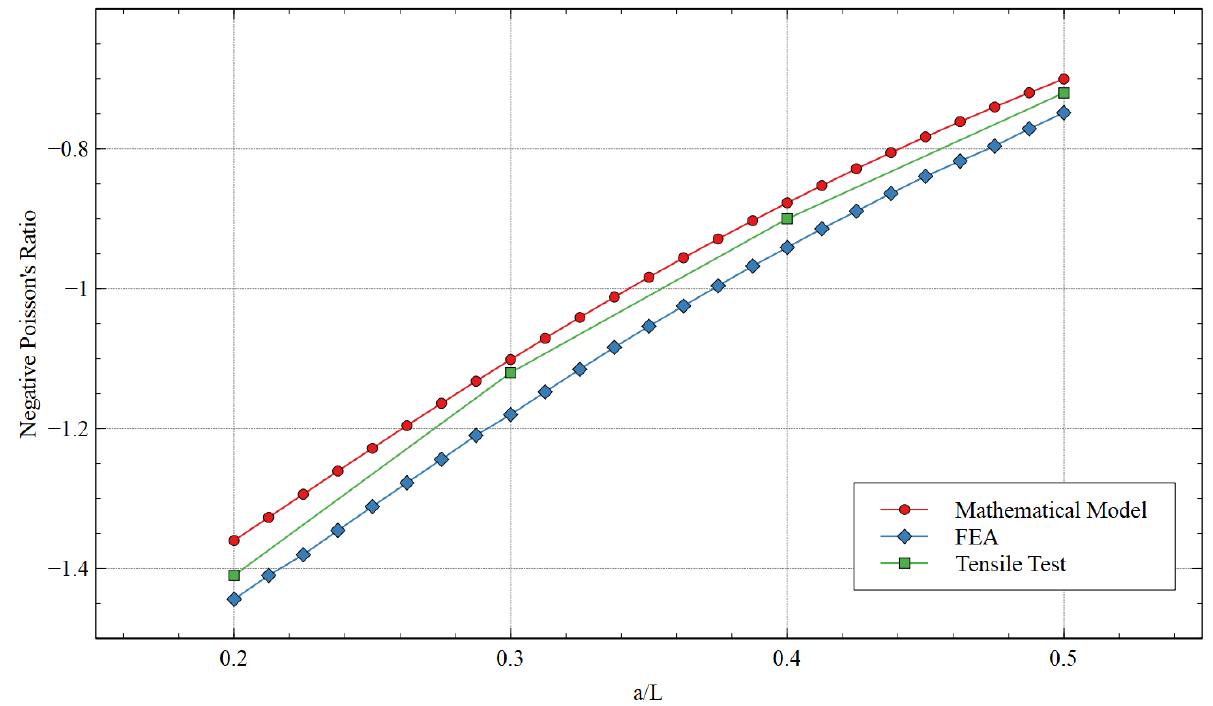
Figure 14. Poisson’s ratio obtained via the mathematical model, FEA, and tensile testing for loading in the y-direction.